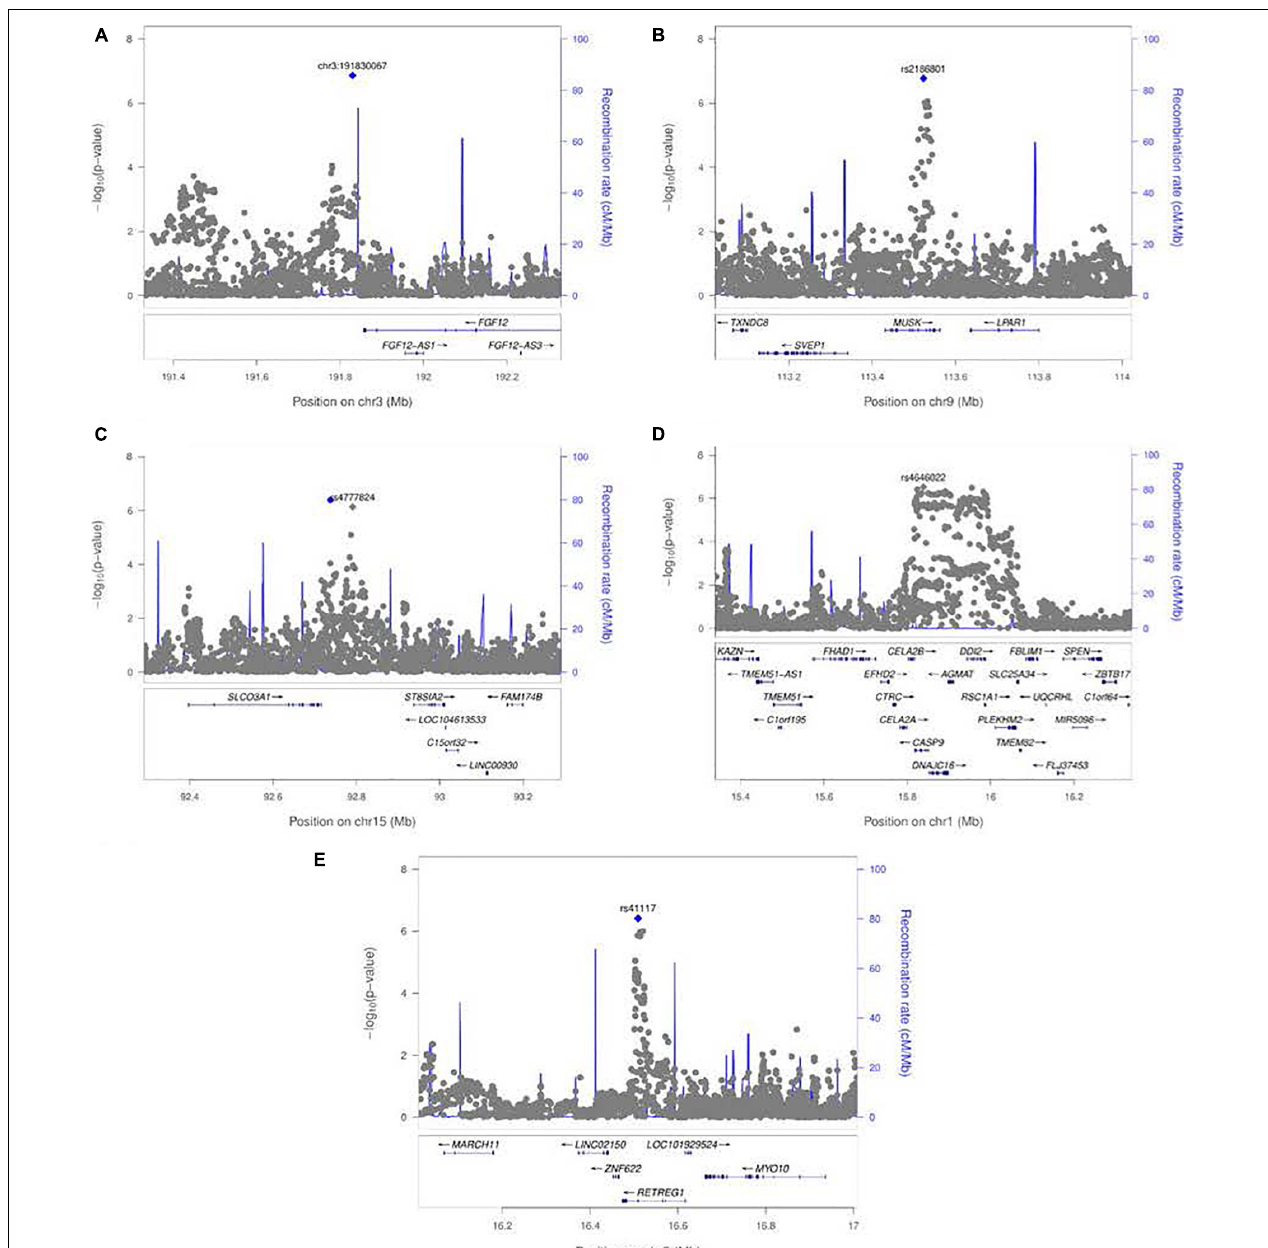
FIGURE 5 | LocusZoom plots for the 1 df test of G × E interaction between maternal exposures and SNPs near their respective peak signals from meta-analysis over both GENEVA and POFC studies. (A) Peak on chr. 3 near FGF12 from the test for G × Smoking interaction shown in Figure 3A . (B) Peak on chr. 9 near MUSK from the test for G × Smoking interaction shown in Figure 3A . (C) Peak on chr. 15 near SLCO3A1 from the test for G × Alcohol interaction shown in Figure 3B . (D) Peak on chr. 1 near CASP9 for G × Vitamin interaction shown in Figure 3C . (E) Peak on chr. 5 near RETREG1 from the test for G × Vitamin interaction shown in Figure 3C